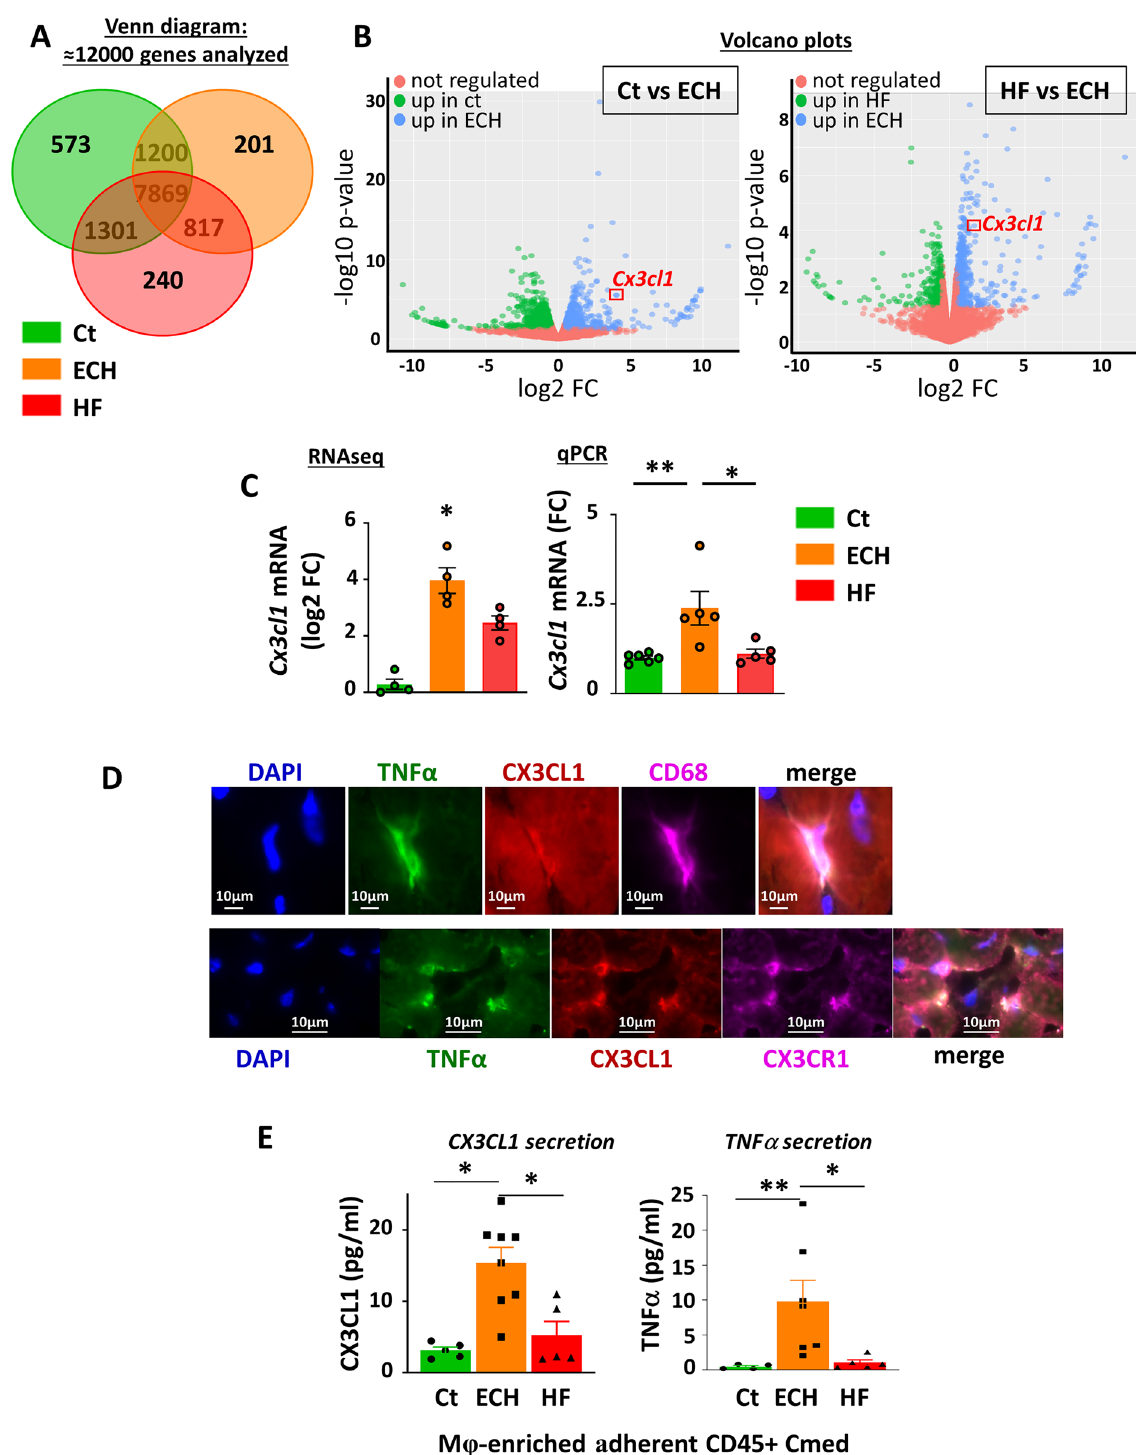
Figure 3. Cardiac ECH CD64 + Mφ are characterized by a typical induction of Cx3cl1 mRNA and a co-secretion of CX3CL1 and TNFα, as compared to Ct and HF counterparts. ( A ) RNAseq transcriptomic analysis: three-way Venn diagrams. ( B ) Volcano Plots showing the number of genes differentially expressed between ECH and Ct or ECH and HF CD64 + Mφ . ( C ) Analysis of Cx3cl1 mRNA levels in isolated cardiac CD64 + cells by RNAseq (n = 4 mice/group, normalization and differential analysis were performed with the glm edgeR package) and qPCR (n = 6 (Ct), 5 (ECH) and 5 (HF) mice, Kruskal–Wallis followed by Dunn post-hoc test; * p < 0.05, ** p < 0.01). ( D ) Typical immuno-fluorescent stainings of cardiac sections from iso-infused ECH mice with anti-TNFα, CX3CL1, CD68 or CX3CR1 Abs. ( E ) Multiplex CX3CL1 and TNFα analysis in Cmed from adherent Mφ - enriched CD45 + cells prepared as described in Fig. 2A; n = 5 (Ct), 8 (ECH) and 5 (HF) mice, Kruskal–Wallis followed by Dunn’s post-hoc test; * p < 0.05, ** p <